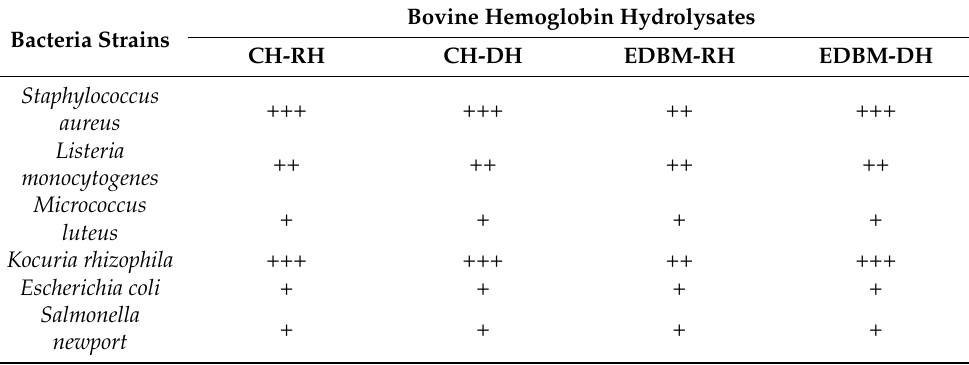
Table 1. Antibacterial activity of bovine hemoglobin hydrolysates. Bacteria